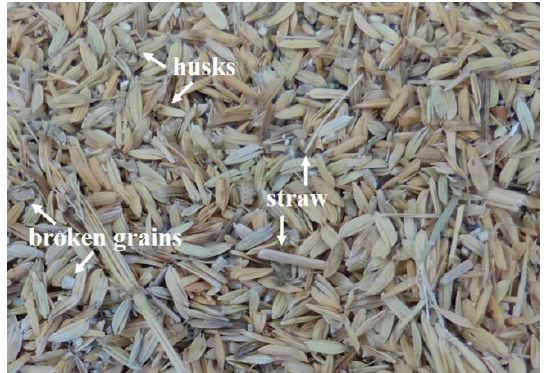
Figure 1. Photo of rice processing residue obtained in 2018 at the Rice Company ‘Sur del Jíbaro’ in Sancti Spíritus, Cuba. Proportion (in %weight) of the by-products: straw 1%, husk 54%, broken grains 44%.